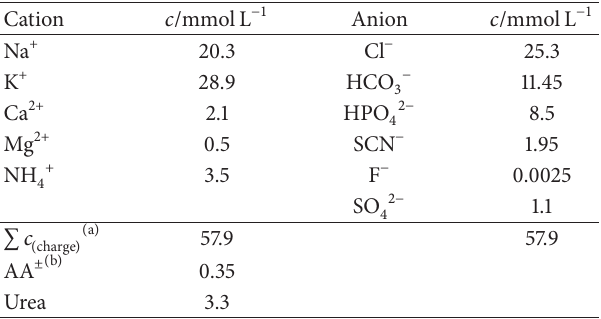
Table 1: Analytical concentrations of components in synthetic